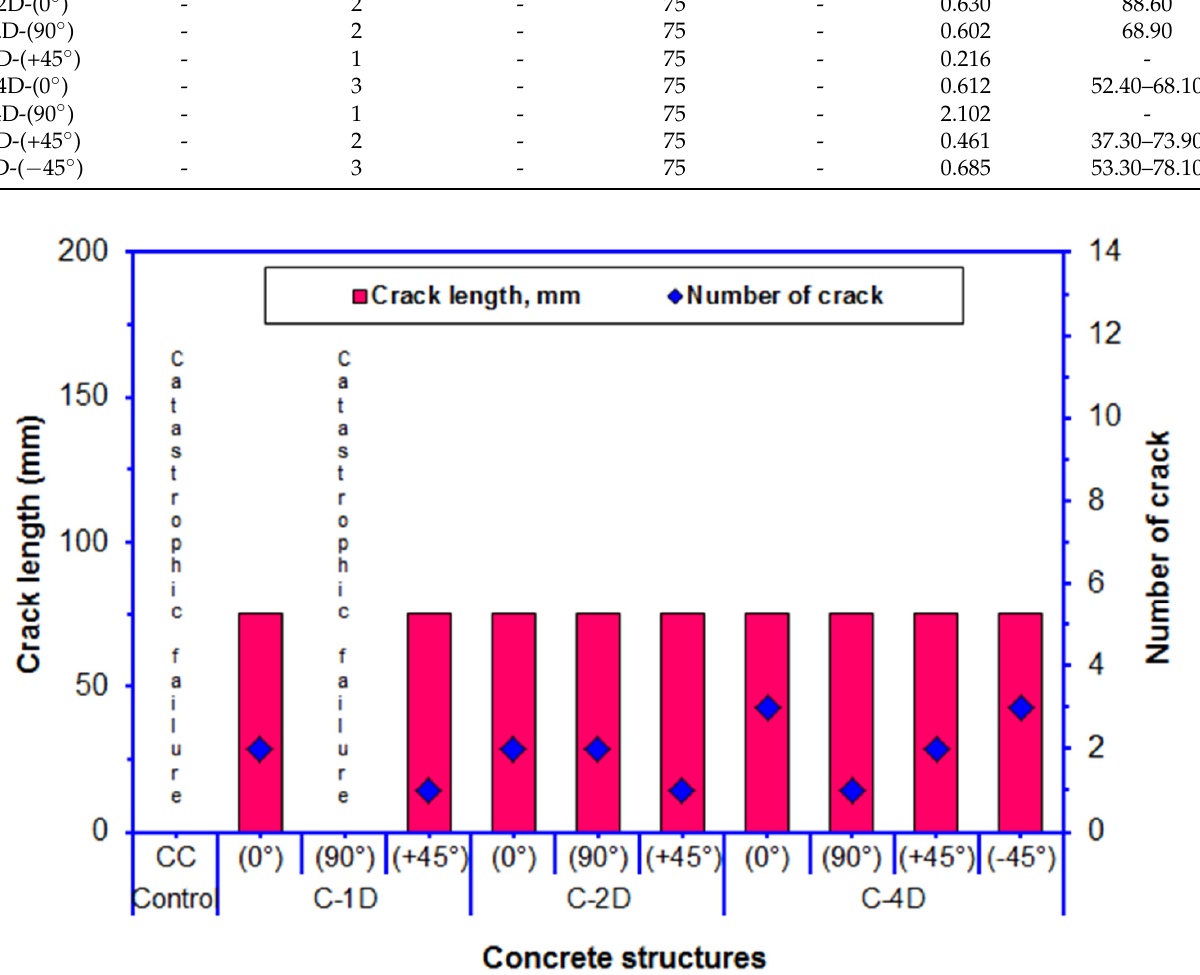
Figure 18. The number of cracks and their length in the failed samples after the off-axis four-point flexural test.